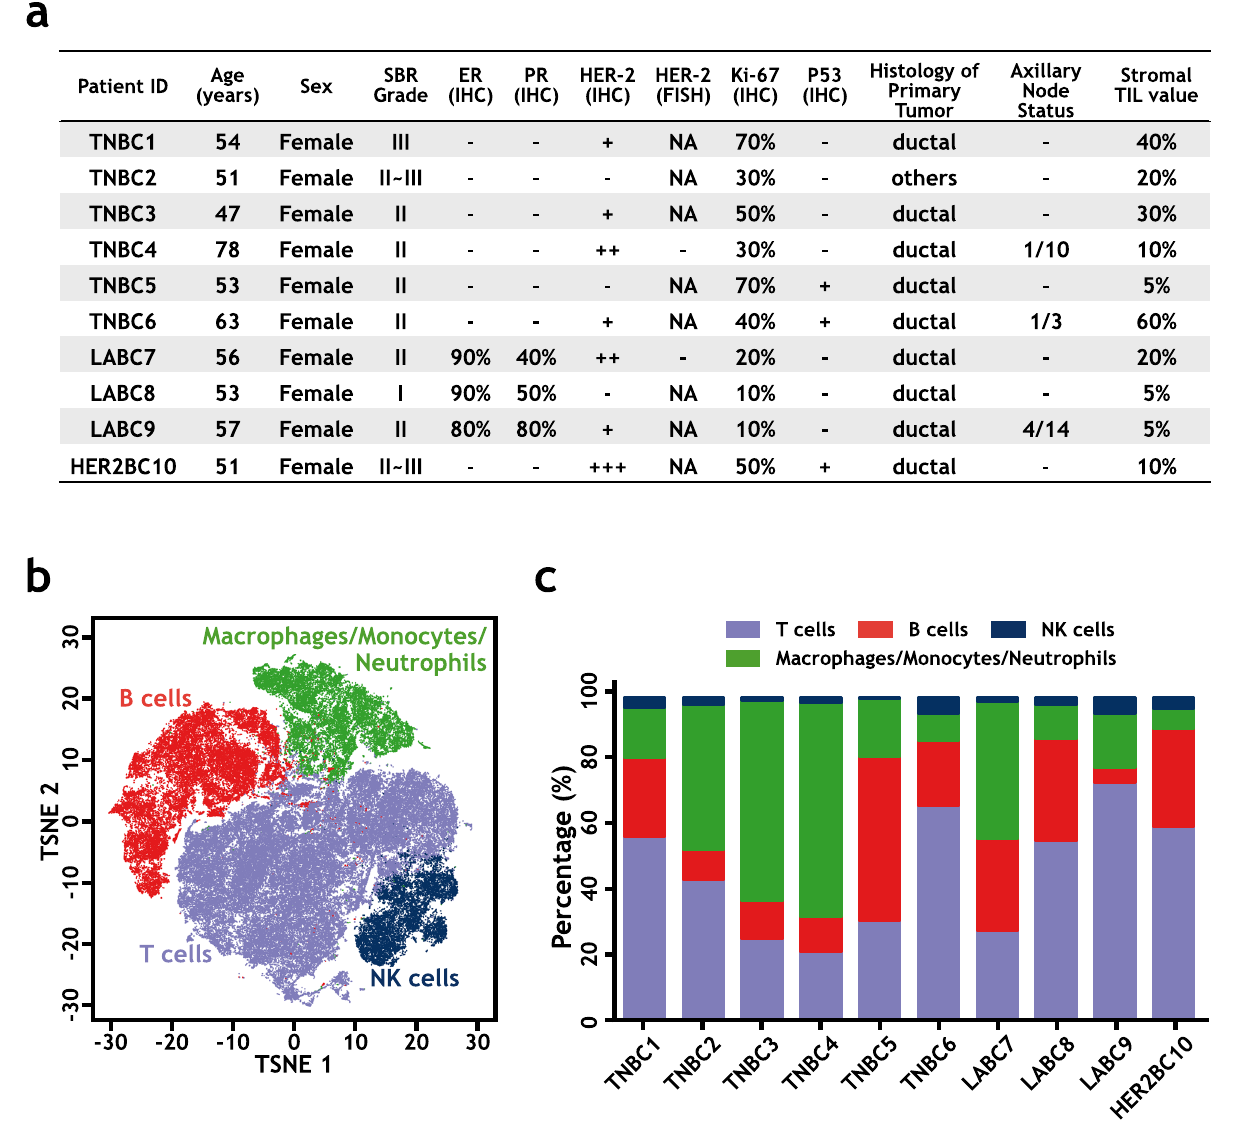
Fig. 1 Heterogeneity of immune cells in human breast cancer patients. a Clinical information of breast cancer patients involved in the current study. b The t-distributed stochastic neighbor embedding (t-SNE) projection of the immune cell atlas constructed from all patient samples. Each dot represents a cell, and major cell types are marked according to Supplementary Fig. 2a. c Distribution of major in fi ltrated immune cell types in each breast cancer sample. Source data are provided as a source data fi